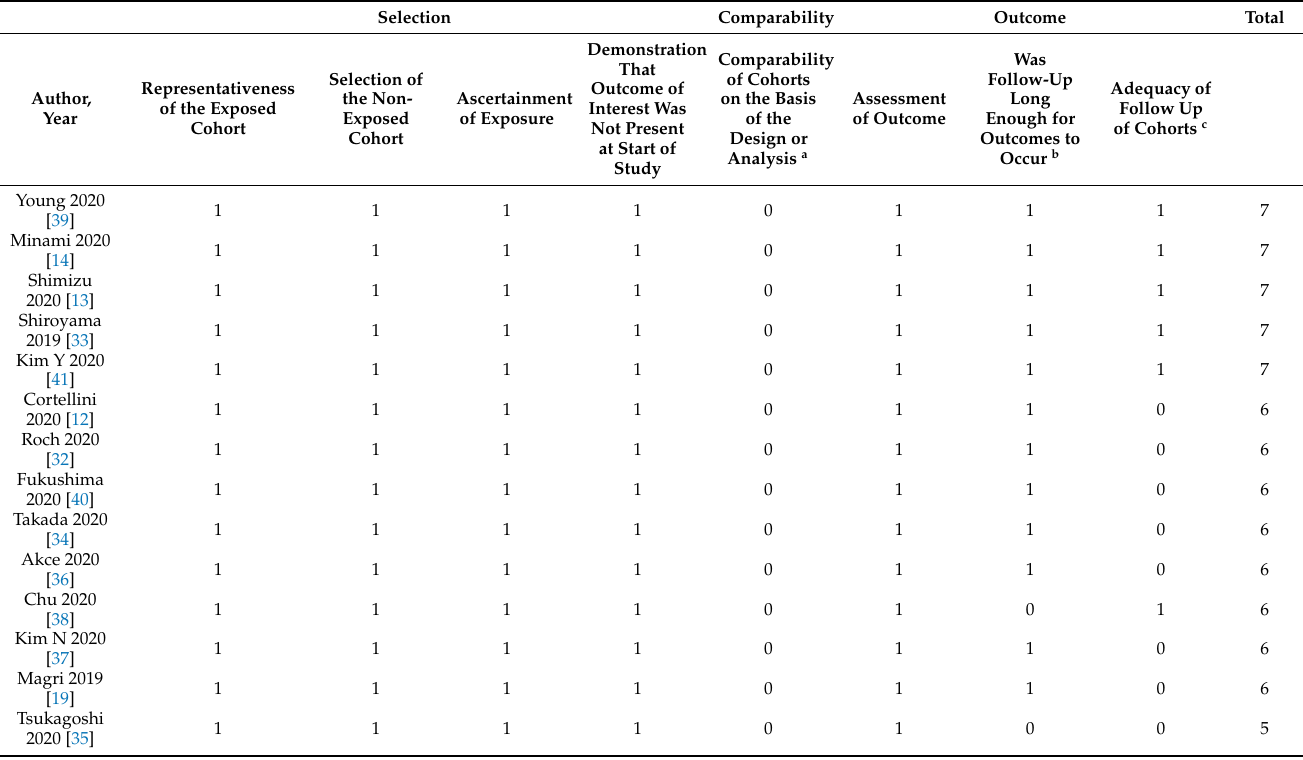
Table 2. The Newcastle-Ottawa Scale (NOS) of the studies included in the meta-analysis.